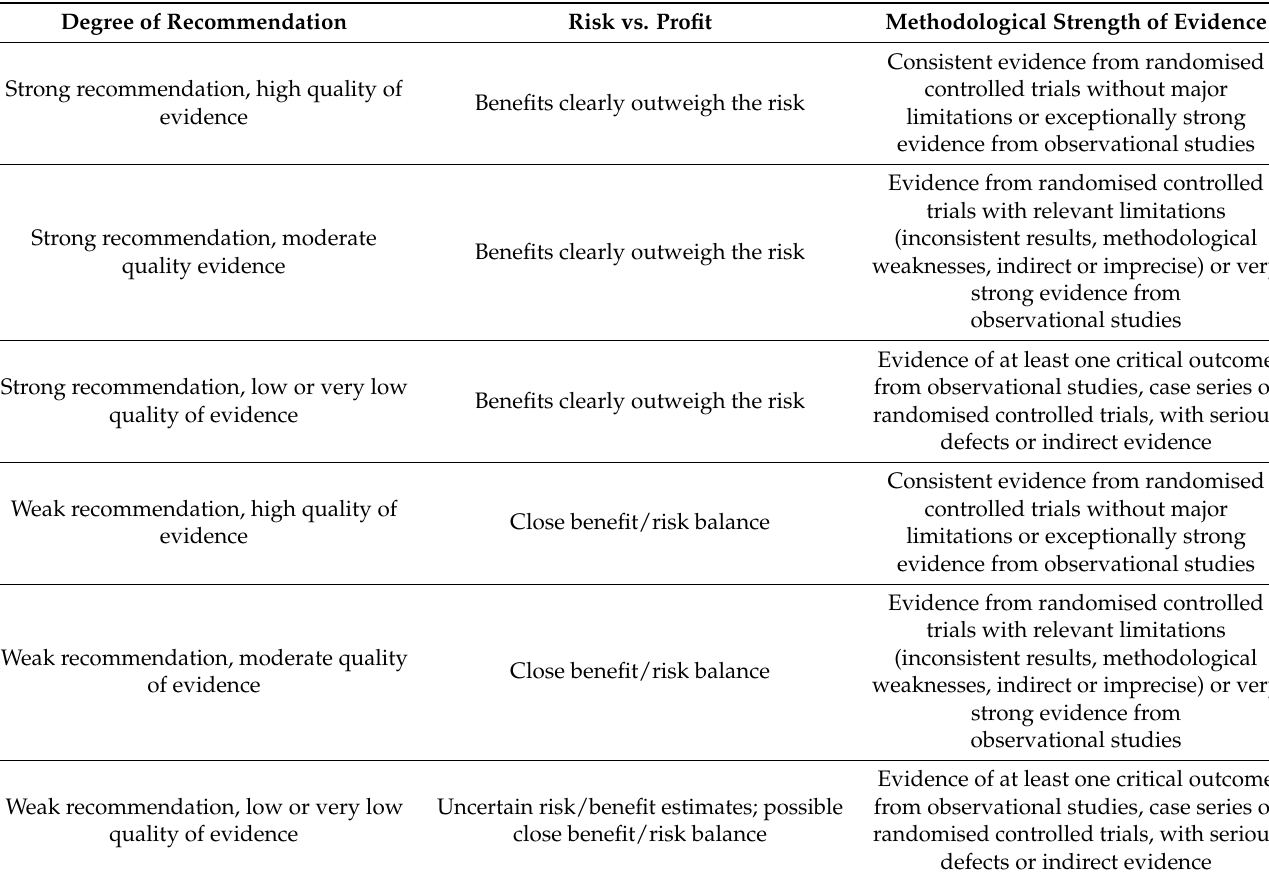
Table 2. Classification of